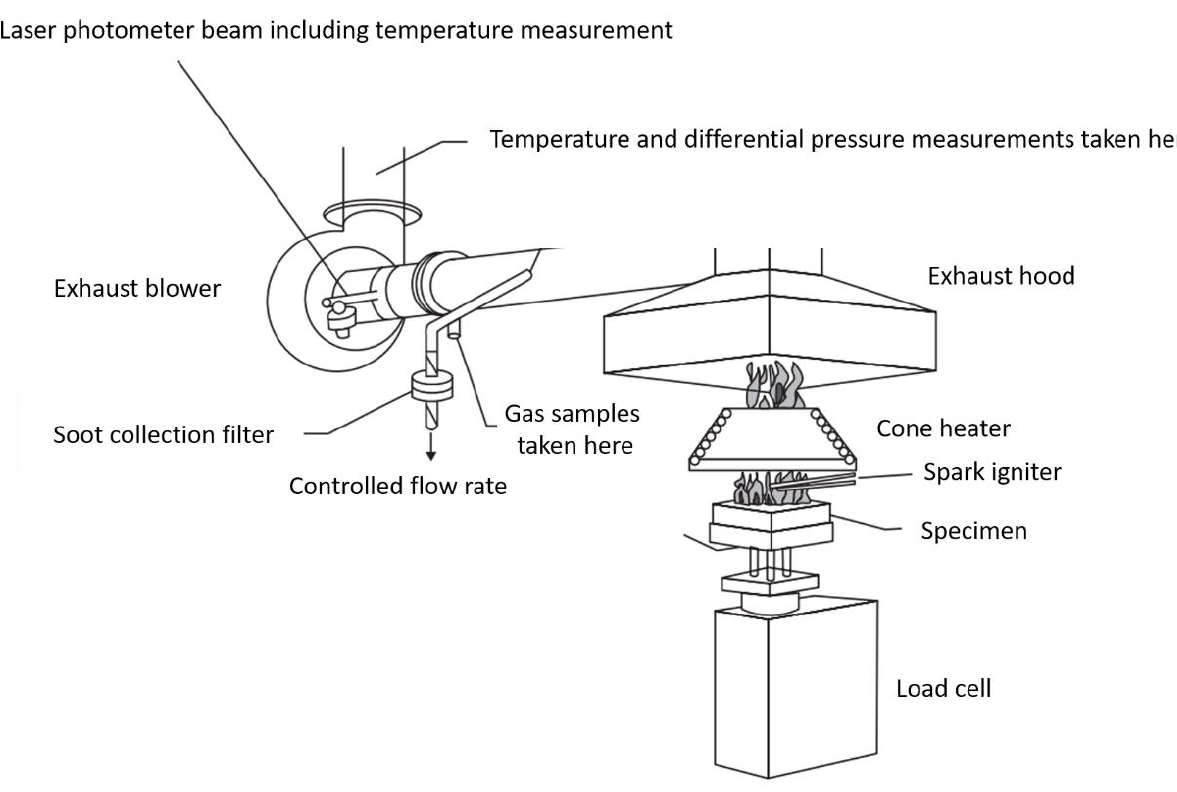
Figure 12. Schematic of a cone calorimeter. Reprinted with permission from Ref. [72]. Copyright 2009, Elsevier.